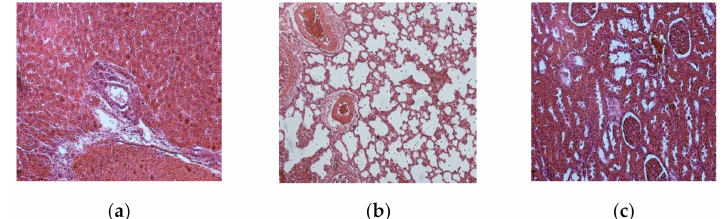
Figure 7. Morphology of the investigated organs for the Tween 80-treated group: ( a ) liver normal morphology, col.HE, x20; ( b ) lung extensive vasodilatations, col.HE, x20; ( c ) kidney normal morphology, col.HE, x20.